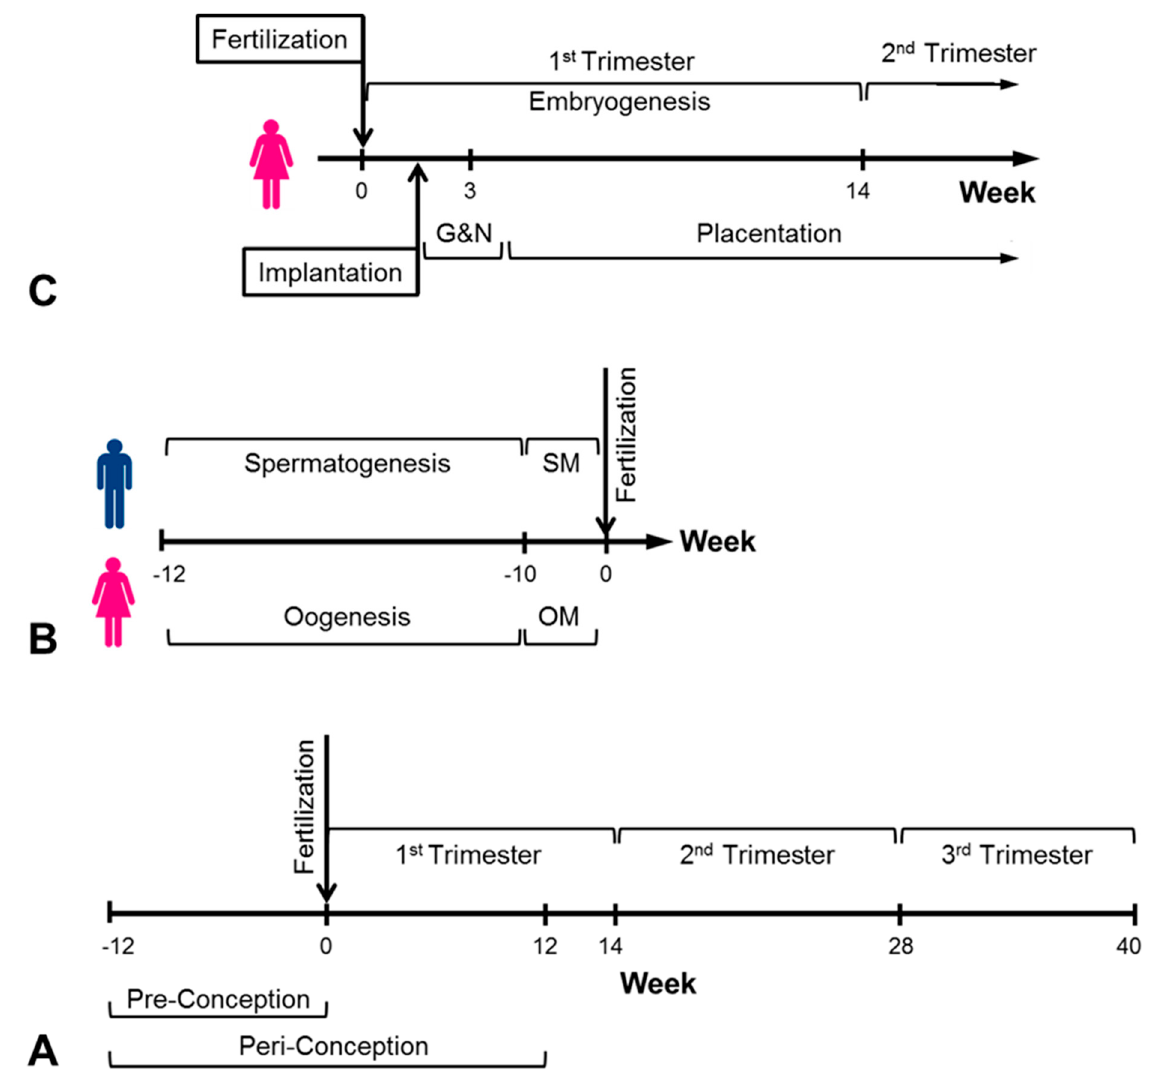
Figure 1. Schematic description of critical time periods during the human reproductive cycle. ( A ) Complete reproductive cycle; ( B ) The pre-conception period (SM—sperm maturation, OM—oocyte maturation); ( C ) Embryogenesis and placentation (G&N—gastrulation and neurulation).